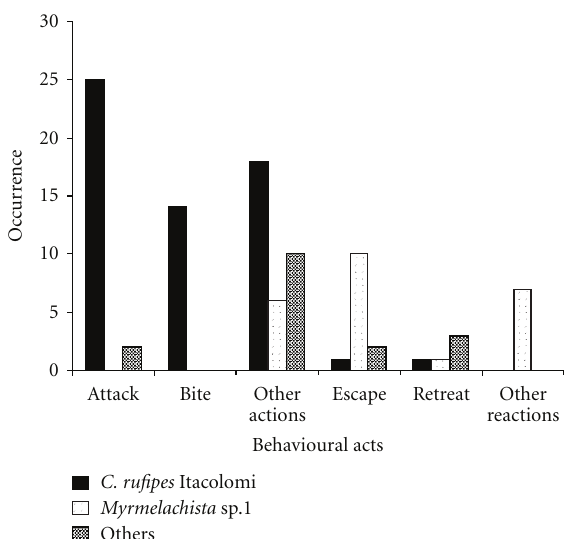
Figure 1: Action and reaction behavioural occurrences for C. rufipes , Myrmelachista sp.1 ants, and other morphospecies assem- blages during field experiments in the Itacolomi State Park (Ita- colomi). The “other actions” and “other reactions” are grouped together because of their low frequency.